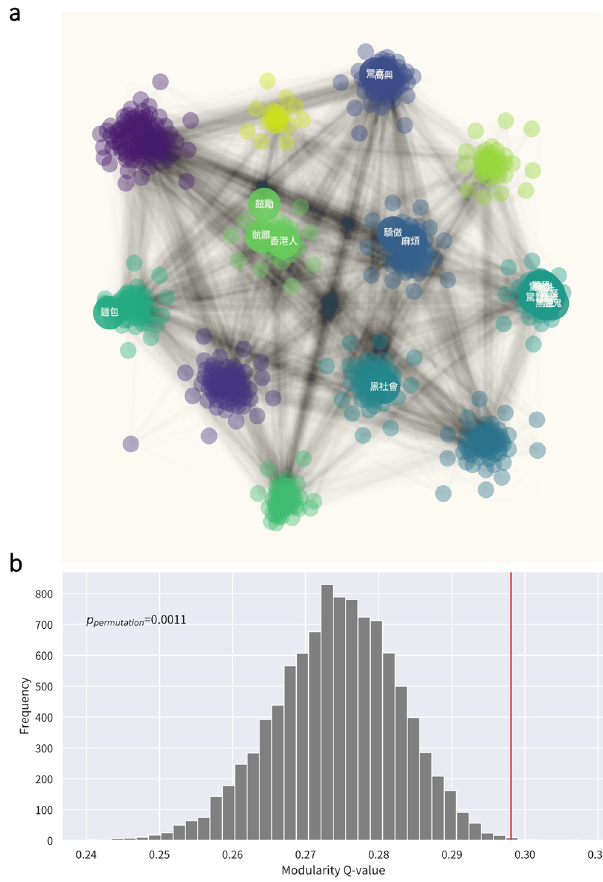
Figure 4. Hubs and community detected in network analysis and stability test. ( a ) Large-scale visualization of hubs and communities in the G emotion network. ( b ) Robustness of community detection. The histogram bars are modularity scores (Q-value) of 10,000 permutation graphs. The vertical line is the Q-value of the original emotion graph. p permutation = 0.0011 suggested that the community structure of the emotion graph was